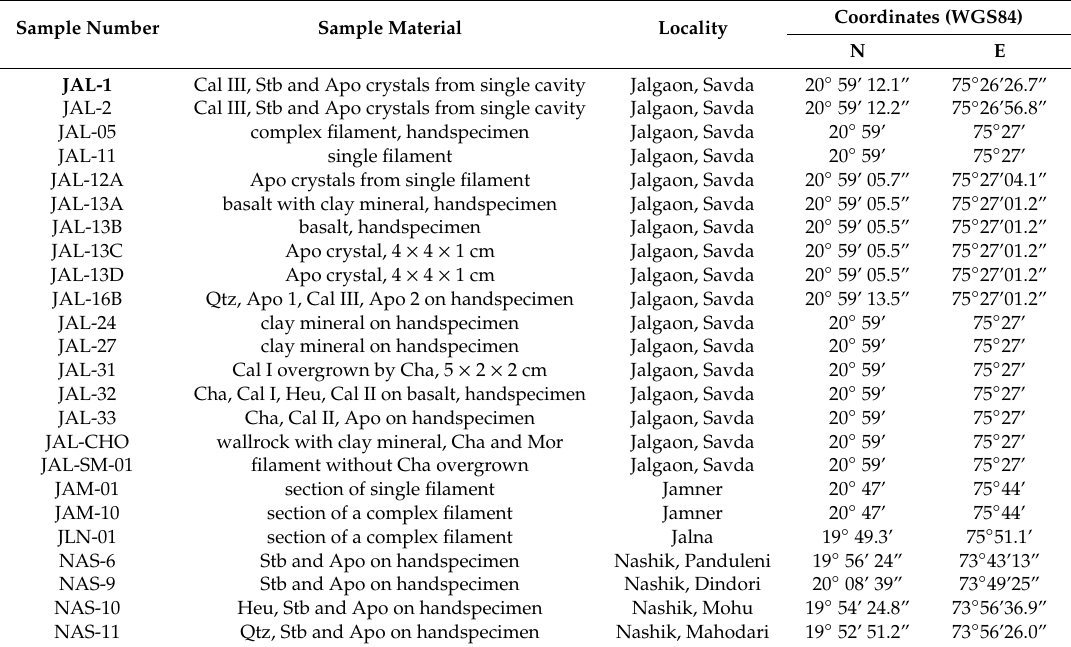
Table 2. Localities of the investigated samples from the Deccan volcanic province (India). Abbreviations: Apo = apophyllite, Cal = calcite, Cha = chalcedony, Heu = heulandite, Qtz = quartz, Sap = saponite, and Stb = stilbite.